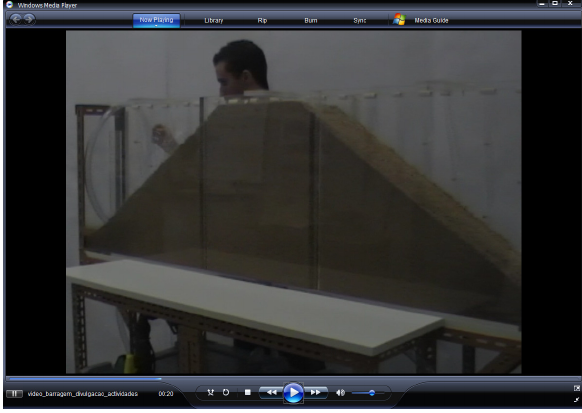
Figure 2. Earth dam small scale